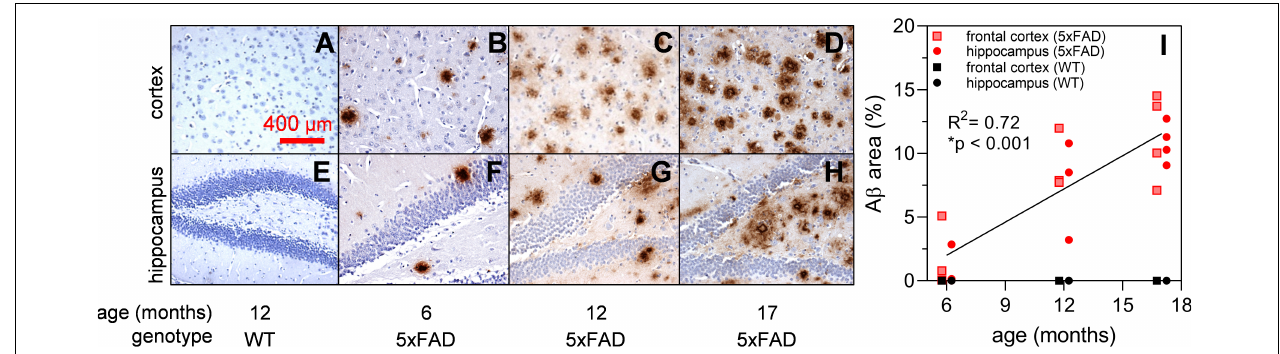
FIGURE 1 | Expression of A β in 5xFAD mouse brain at 6, 12, and 17 months of age. A β labeling using monoclonal mouse antibody 1E8 (brown) and counterstained with haematoxylin (blue). Representative cortical and hippocampal parasagittal serial sections of 12-month-old wild type (A,E) ; and 5xFAD mice at ages 6 (B,F) , 12 (C,G) , and 17 (D,H) months of age. There is a significant increase in A β area stained with advancing age in 5xFAD mice (I) Scale bar, 400 µ m.